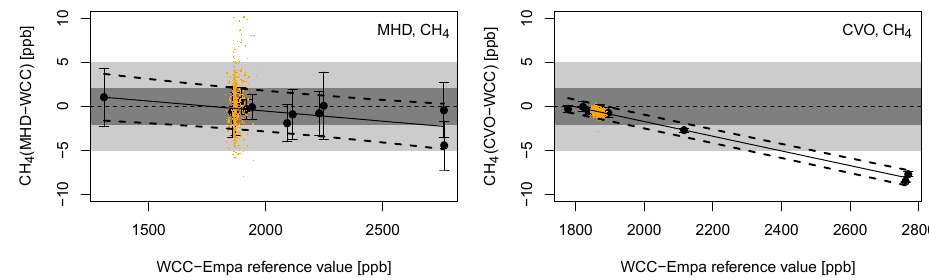
Figure 13. Results of the CH 4 travelling standard comparisons (performance audits) at MHD (left) and CVO (right). The grey areas corre- spond to the WMO/GAW compatibility and extended compatibility goals. The orange points correspond to the observed differences based on hourly data during the ambient air